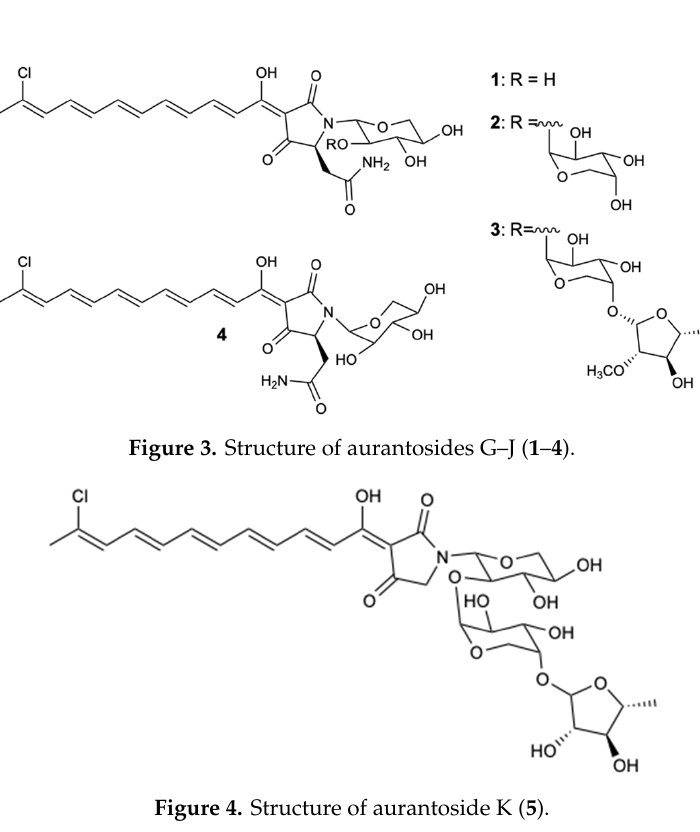
Figure 4. Structure of aurantoside K ( 5 ).